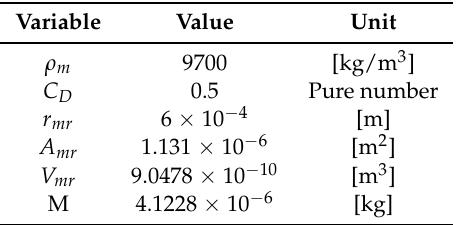
Table 1. Values of the variables in the model of the